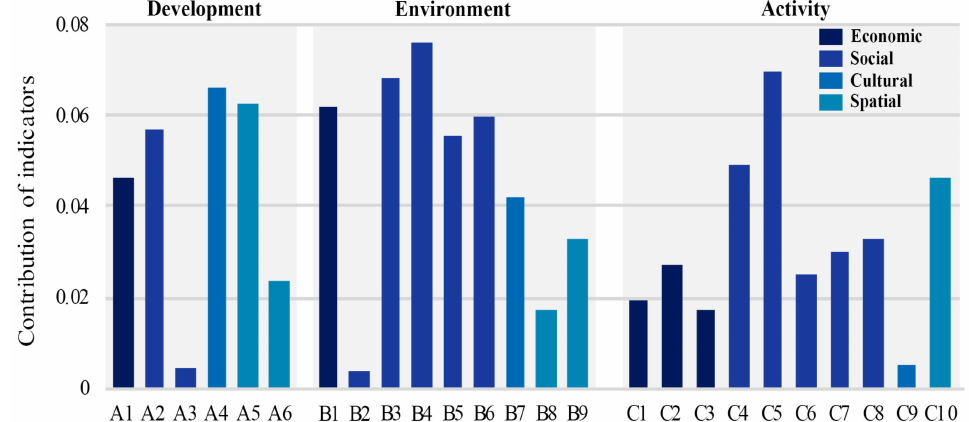
Figure 9. Contribution of each